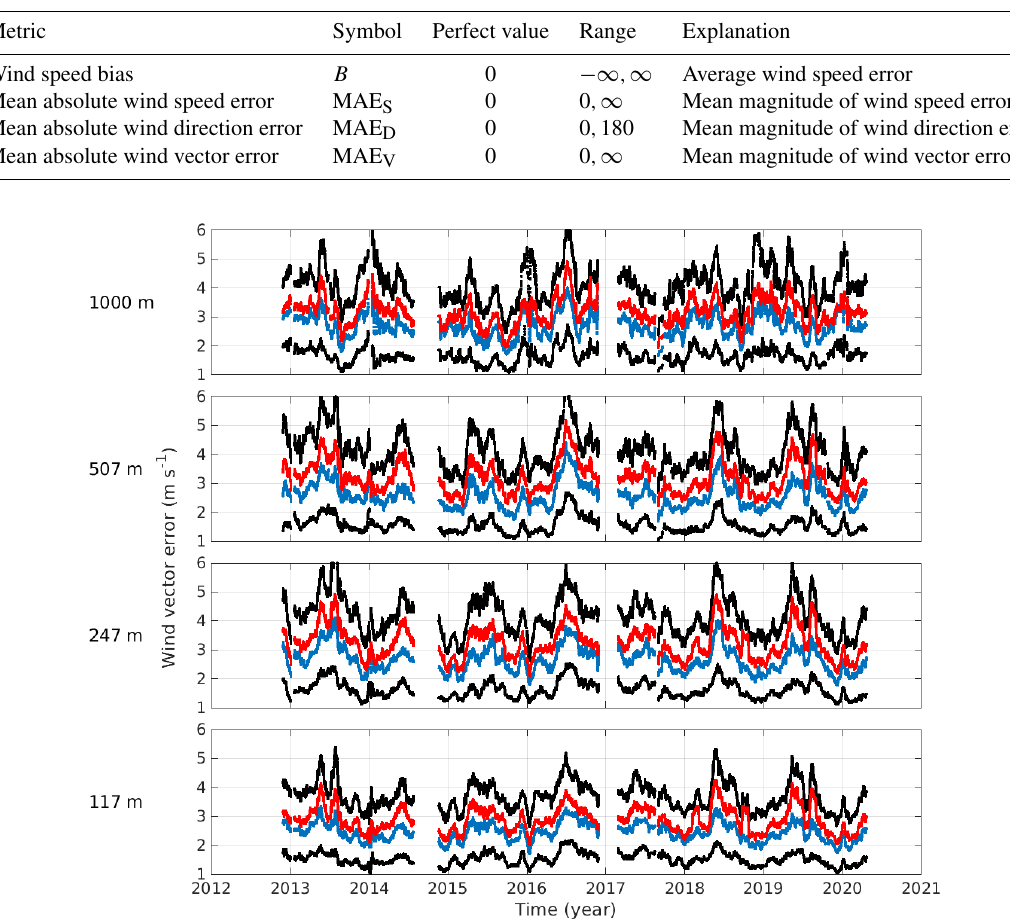
Figure 5. Time series of 30d moving mean (red), median (blue), and 25th and 75th percentiles (black) of wind vector error over SGP at 117, 247, 507, and